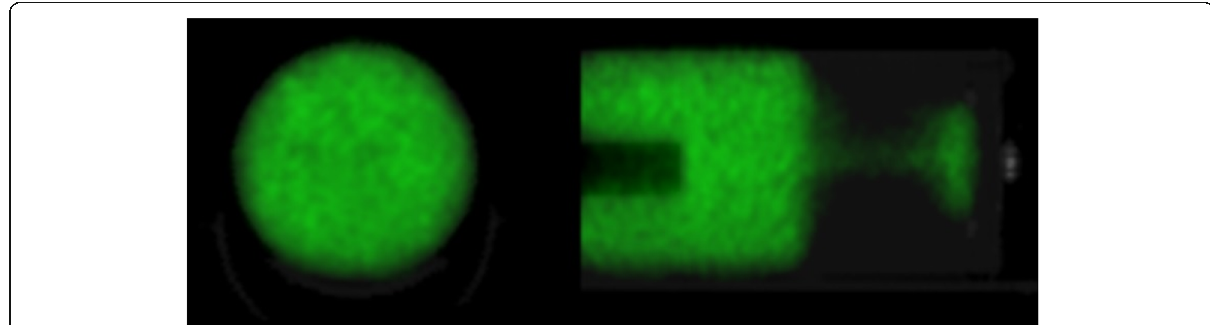
Fig. 1 NEMA-NU4 phantom filled with a uniform activity of 152 Tb, used to derive the count/activity calibration